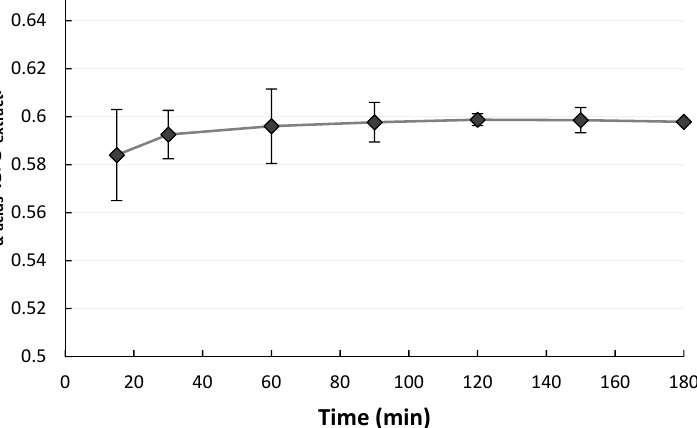
0.6 g/g extract ). As the extraction proceeded, hop extracts equally concentrated in α -acids were obtained due to their similar extraction kinetics.